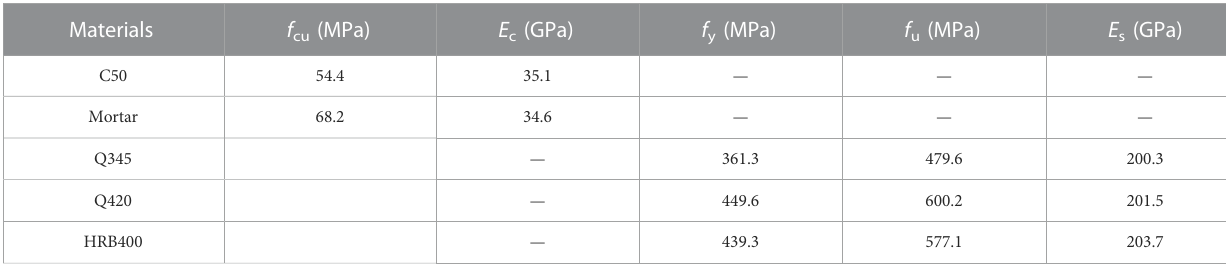
TABLE 1 Material properties of concrete and steel (Zou et al.,